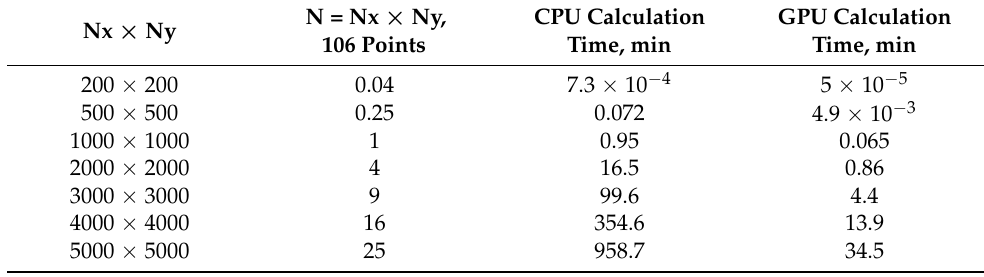
Table 1. Dependence of the computation time on the discretization parameters of the field evaluation grid.